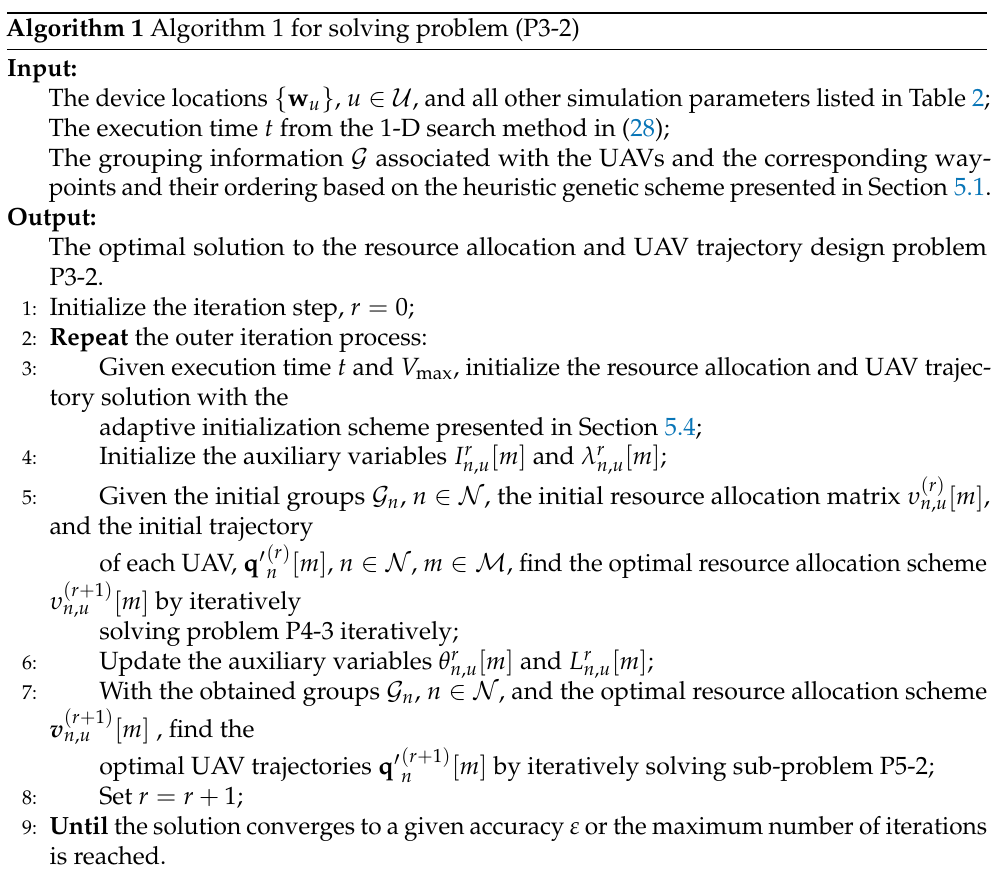
Algorithm 1 Algorithm 1 for solving problem